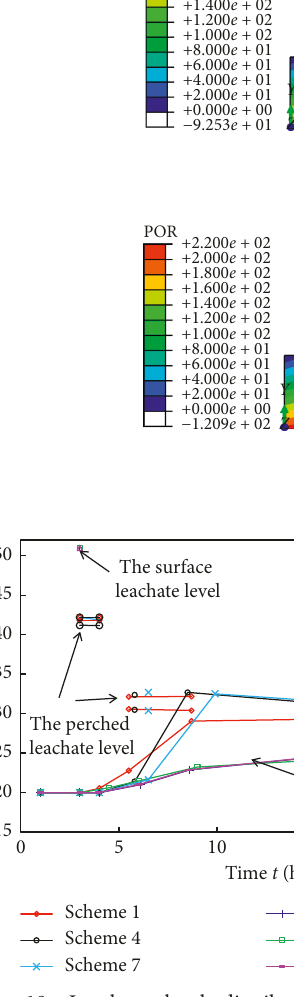
Figure 19: Leachate level distributions of several schemes ( t � 0 − 25h).